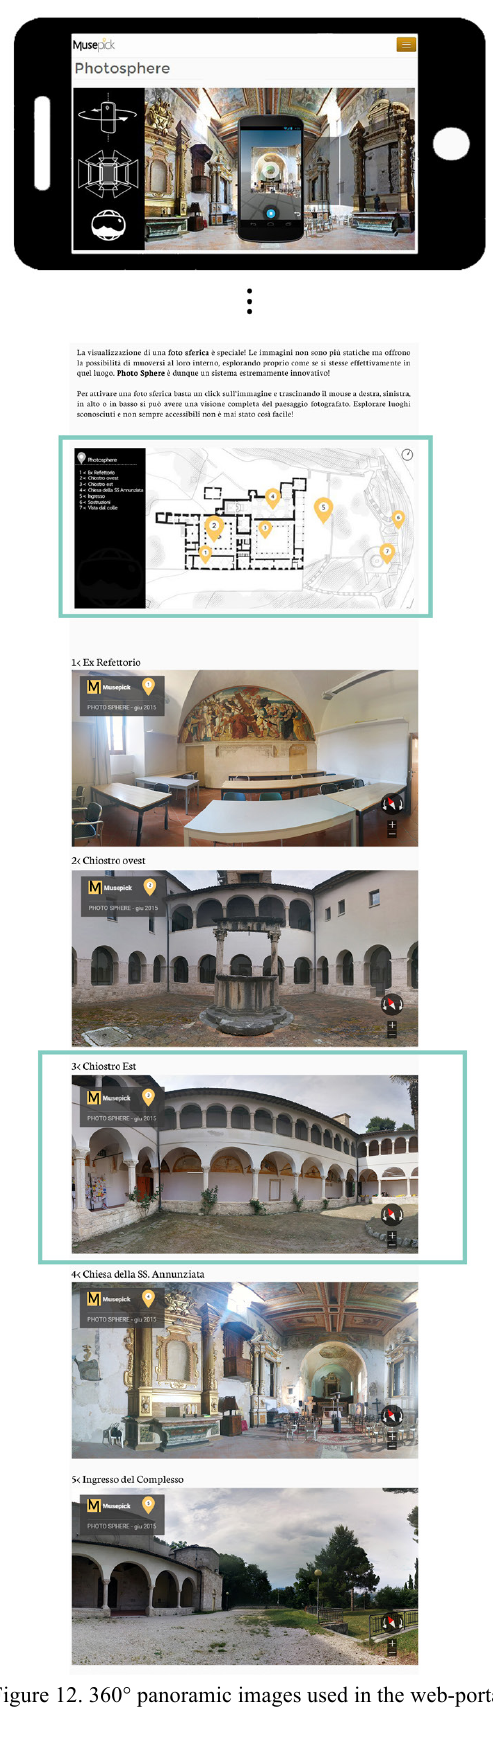
Figure 12. 360° panoramic images used in the web-portal